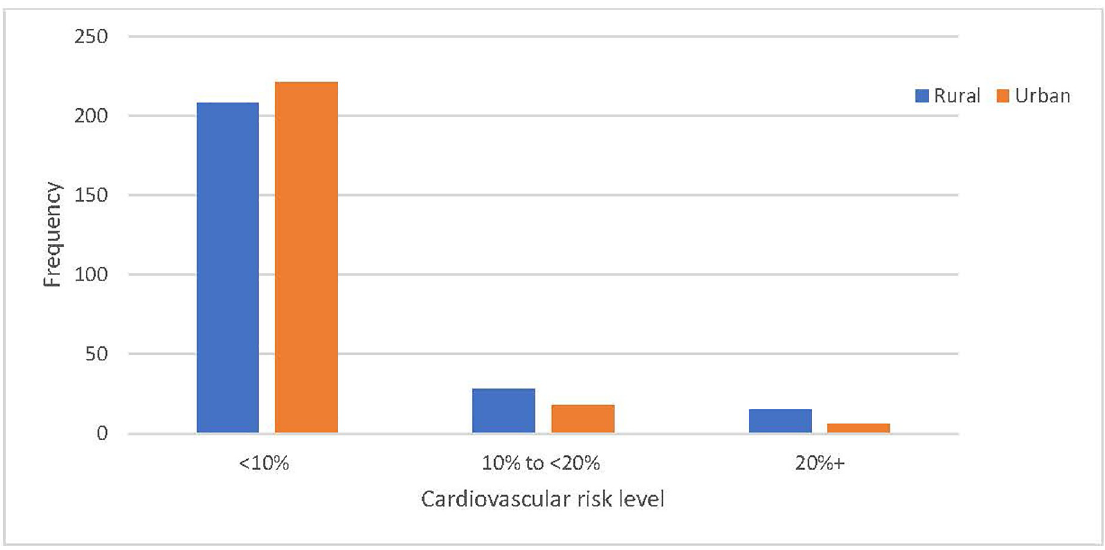
Fig 2. Comparison of distribution of cardiovascular risk score by